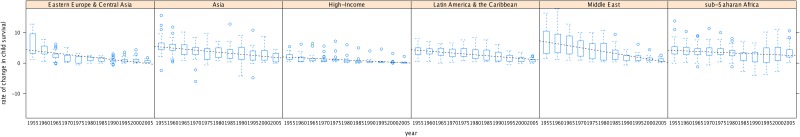
Regional changes in child survival (deaths per 1000 per year), 1950–2010.Note: mean regional trends in changes in child survival are indicated by the black dashed lines.